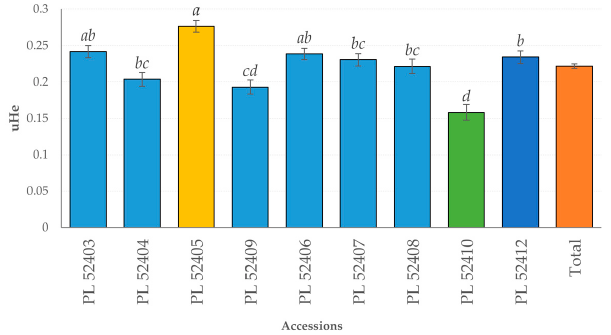
Figure 3. The unbiased genetic diversity coe ffi cient ( uH e ) within nine accessions of Avena macrostachya Bal. ex Cross. et Durieu based on sequence-related amplified polymorphism (SRAP) markers. Homogeneous groups were labeled with the letters. The significance of di ff erences was tested using ANOVA. ( p < 0.05) and post-hoc Tukey’s HSD